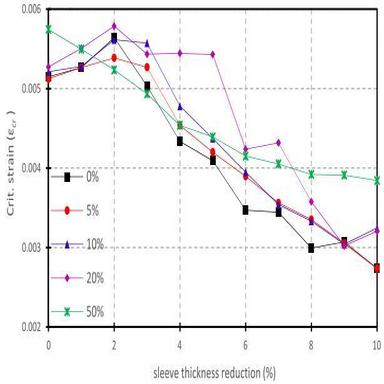
Plots of εcr for Type 2 imperfection.